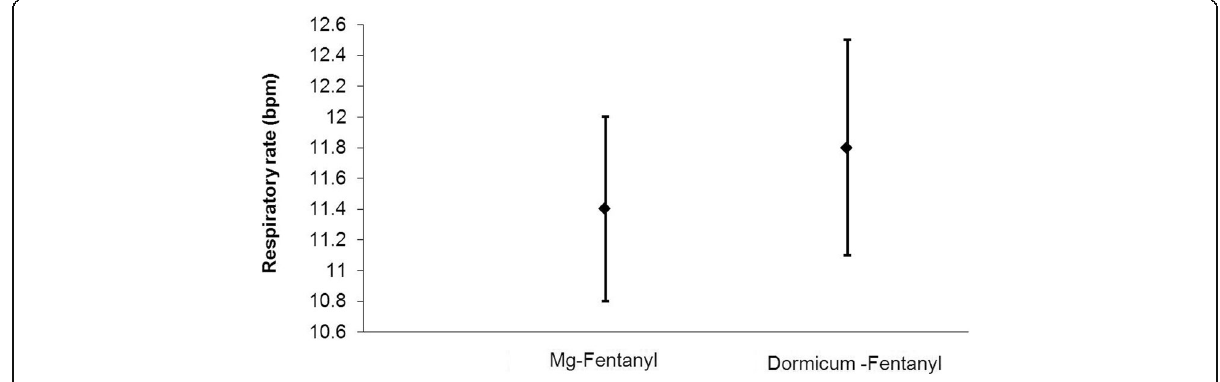
Fig. 5 Average respiratory rates in both study groups. Markers represent means and error bars represent 95% CI